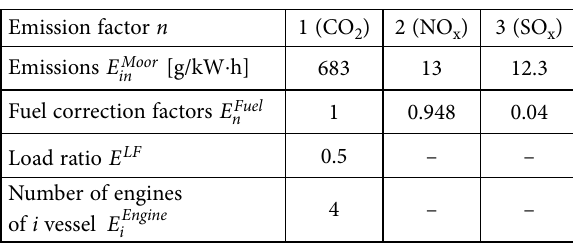
Table 2. Reference values of emission factors while mooring